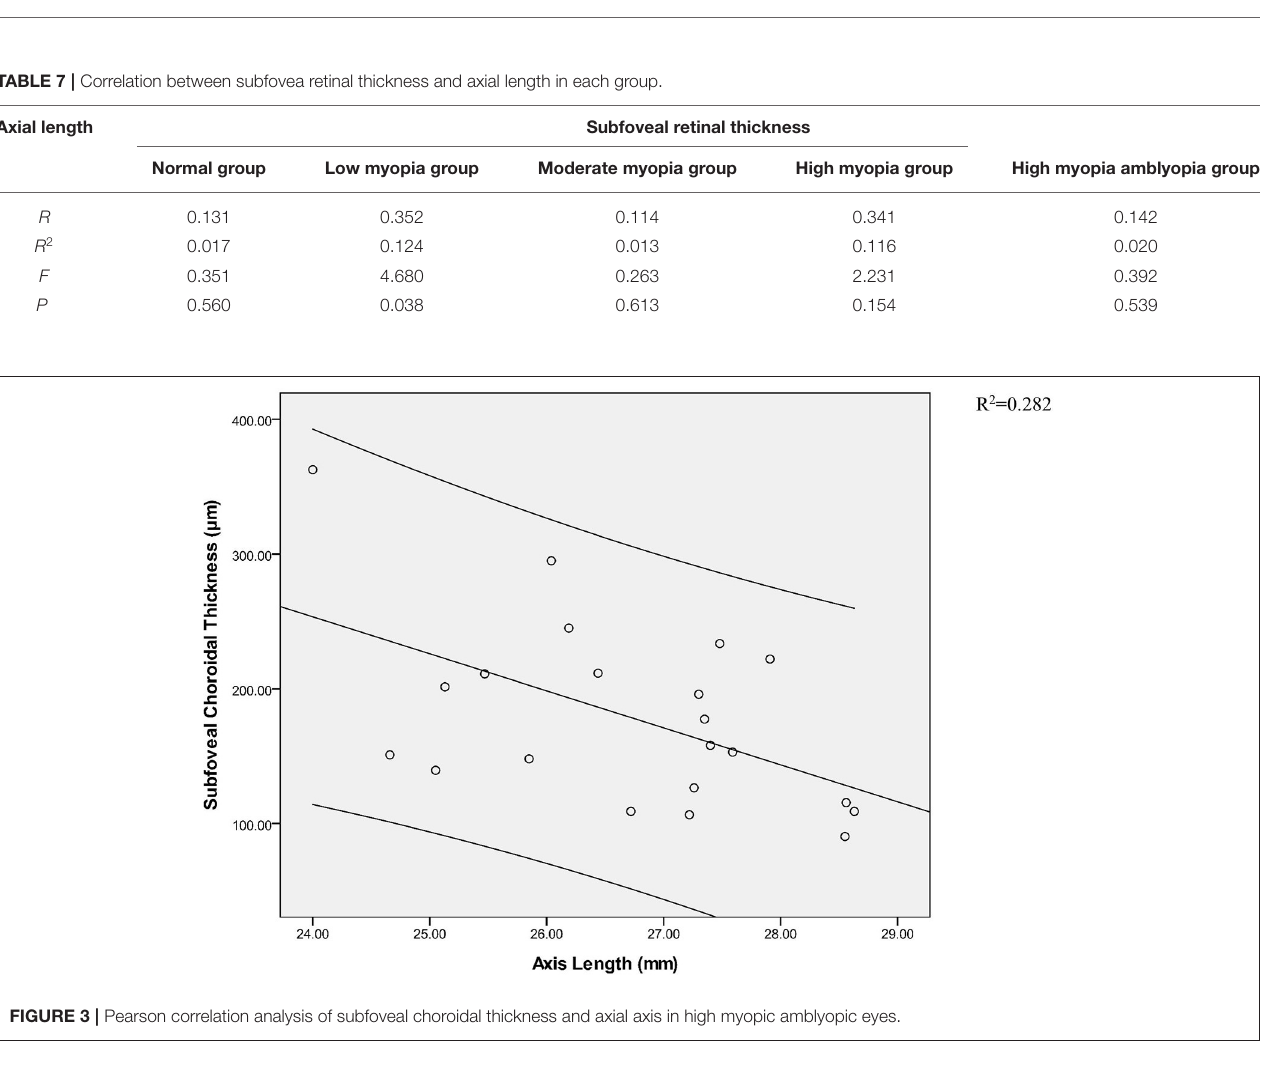
Frontiers in Medicine |